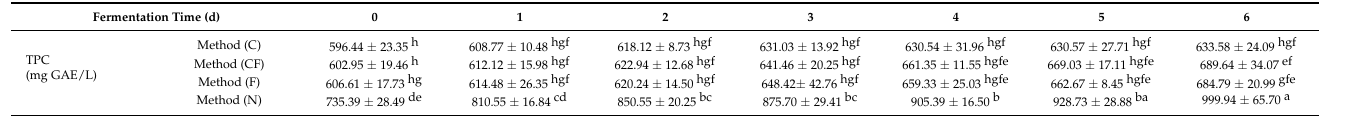
Table 1. Changes of TPC in sea buckthorn juice determined by different